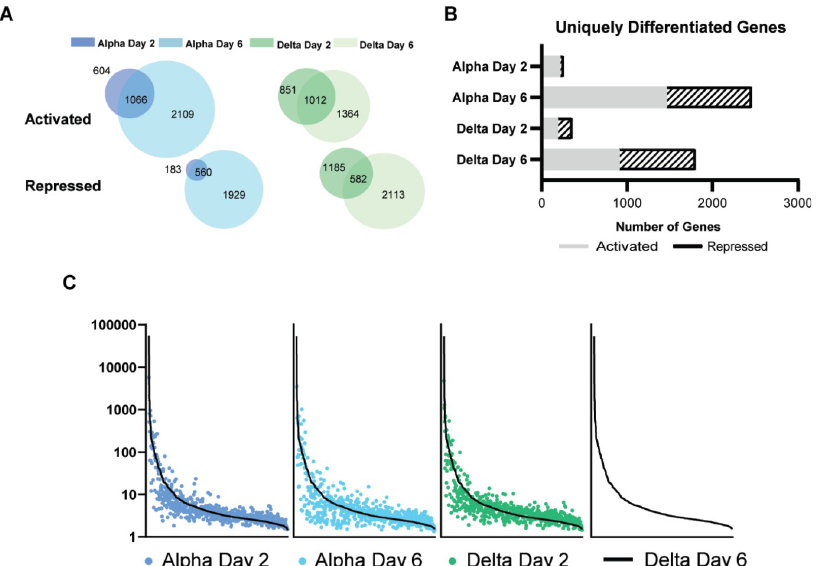
Fig 6. Total transcriptomic analysis of mouse genes in non-challenged mice compared to Alpha and Delta challenged mice at days 2 and 6. RNAseq reads from challenged mice were compared to non-challenged mice to determine differential gene expression (A). Genes that were statistically significant are indicated in relation to challenge day and their relative expression as being activated or repressed. Venn diagrams are shown to illustrate the amount of overlap in significant genes between days 2 and 6. The total number of unique differentially expressed genes are represented per each challenge day and relative expression (B). (n = 4 in Alpha Day 2 and Delta Day 6; n = 5 in Alpha Day 6 and Delta Day